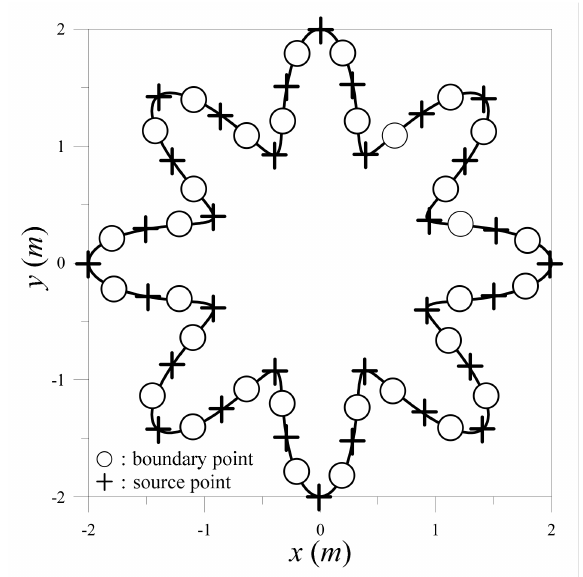
Figure 11. Boundary collocation points.